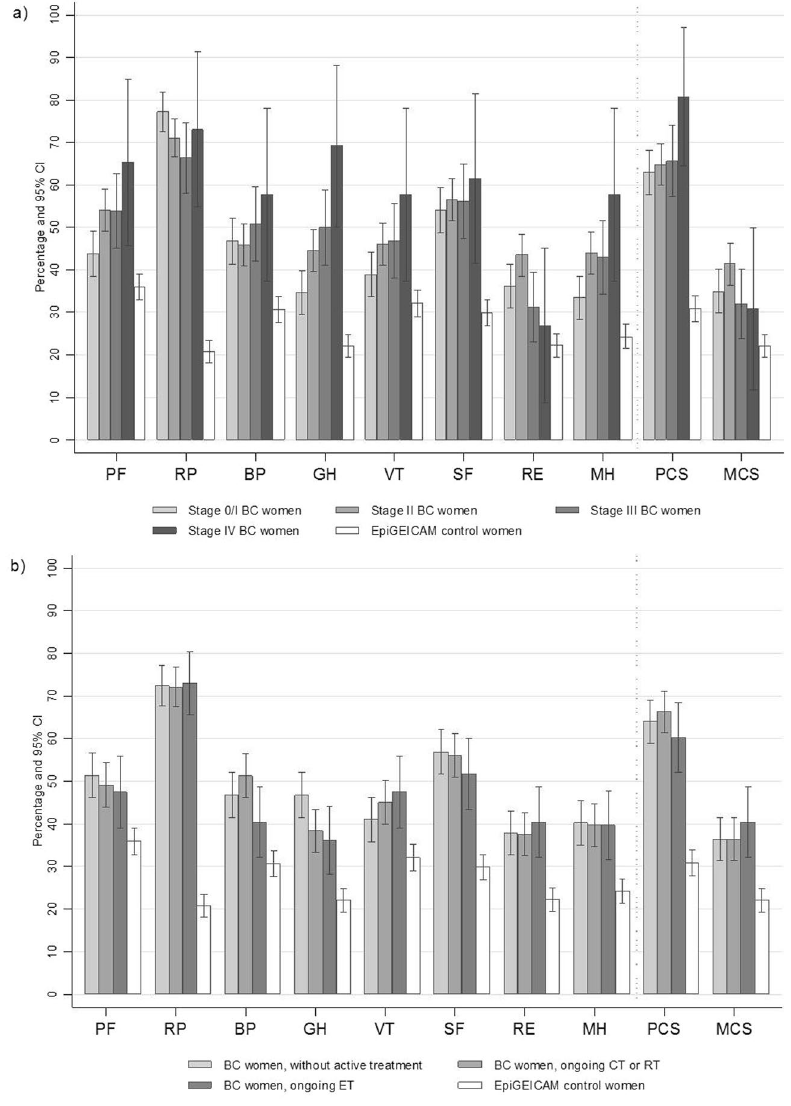
Figure 2. Percentage of women with low scores in the SF-36 scales and component summaries in breast cancer cases stratified by tumour stage (a) and treatment (b), and in control women (EpiGEICAM study). Low scores defined as Norm-based scores five or more points under the Spanish reference population. The category of BC women with ongoing chemotherapy or radiation therapy includes women with or without endocrine therapy; the category of BC women with ongoing endocrine therapy includes those with only endocrine therapy, i.e. not ongoing chemo- or radiation- therapy. BC: Breast cancer; CT: Chemotherapy; ET: Endocrine therapy; RT: Radiation therapy; PF: Physical Functioning; RP: Role-Physical; BP: Bodily Pain; GH: General Health; VT: Vitality; SF: Social Functioning; RE: Role-emotional; MH: Mental Health; PCS: Physical Component